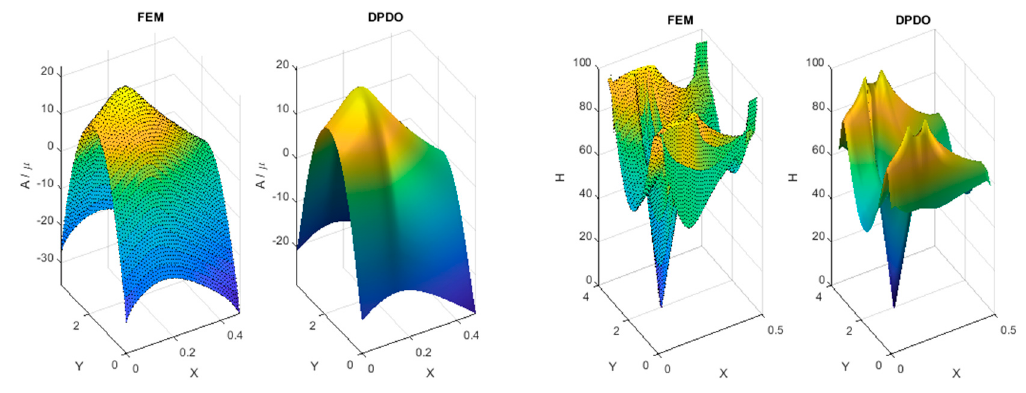
Figure 13. Modified ampere-turn function for winding ‘1 ′ .